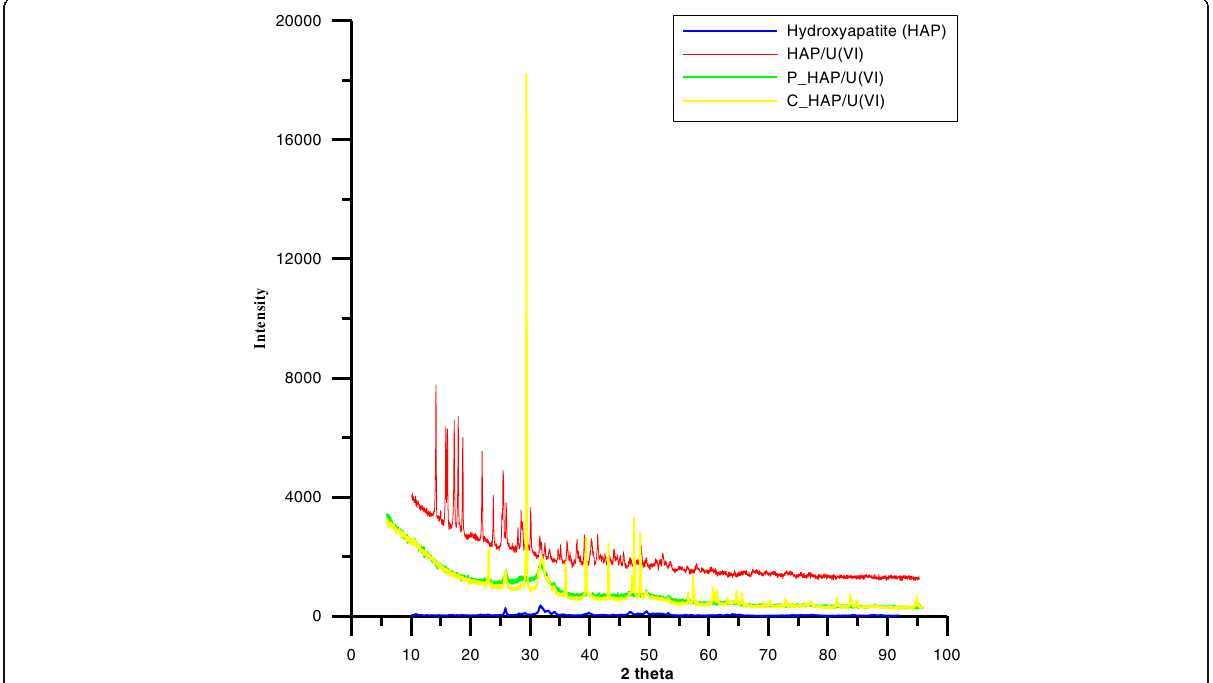
Fig. 1 X-ray diffraction pattern for the nano-hydroxyapatite sample and its modification with adsorbed uranyl